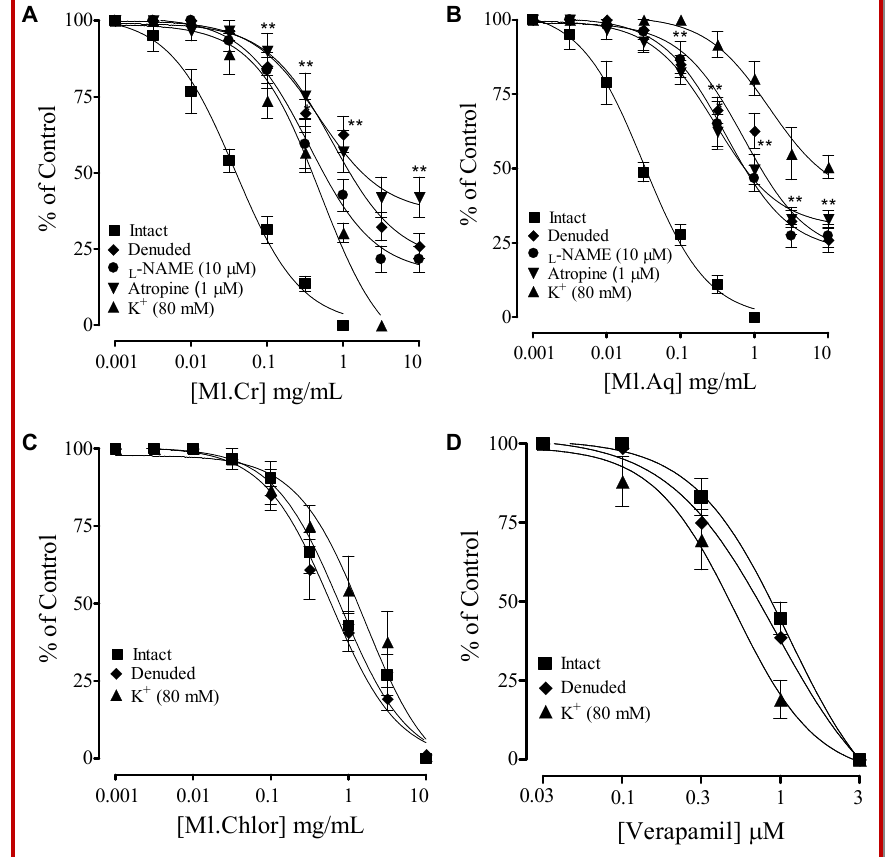
Figure 3. Vasodilator effect of the crude extract of M. longifolia (Ml.Cr), its fractions and verapamil in isolated rat aorta prepara- tions. A and B depict endothelium-dependent (L-NAME/atropine-sensitive) and endothelium-independent vasodilator effect of Ml.Cr and itsaqueous (Ml.Aq) fraction on phenylephrine (PE) pre-contractions and also against high K + pre-contractions, in the intact aortic rings. C depicts endothelium-independent vasodilator effect of the chloroform fraction (Ml.Chlor) of M. longifolia against high K + and phenylephrine (PE) pre-contractions in the intact aortic rings. D depicts endothelium-independent vasodi- lator effect of verapamil against phenylephrine (PE) and high K + pre-contractions. Values shown are mean + SEM of 7 determi- nations. ** p<0.001 compared with